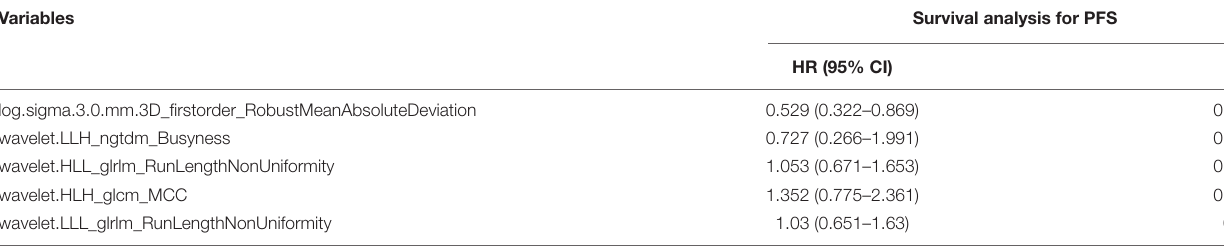
TABLE 4 | Univariate Cox proportional hazard regression for survival.